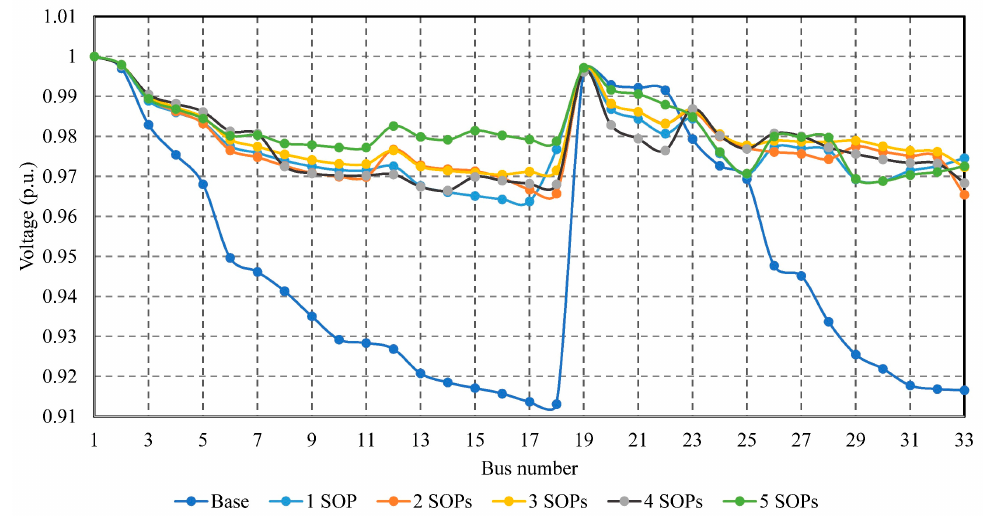
Figure 4. Improvement of the voltage profile at normal loading condition: scenario 9.